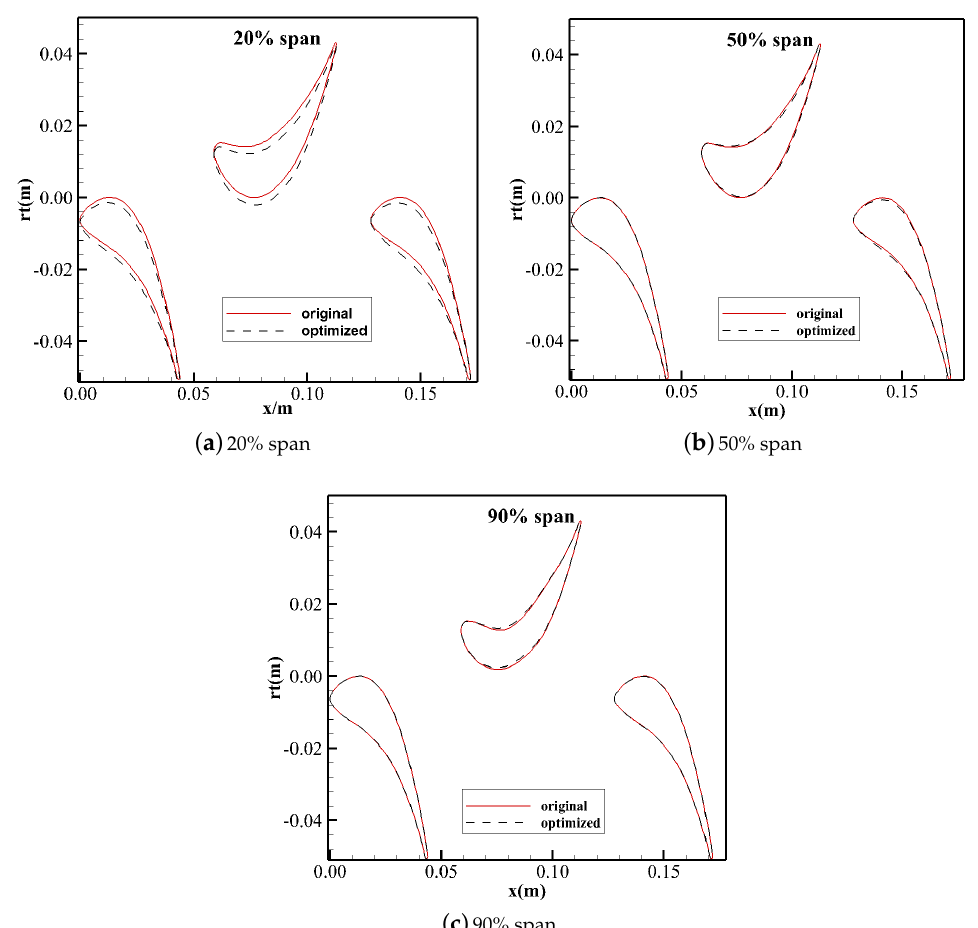
Figure 28. Comparison of original and optimized blade profiles at three different spans for the Aachen